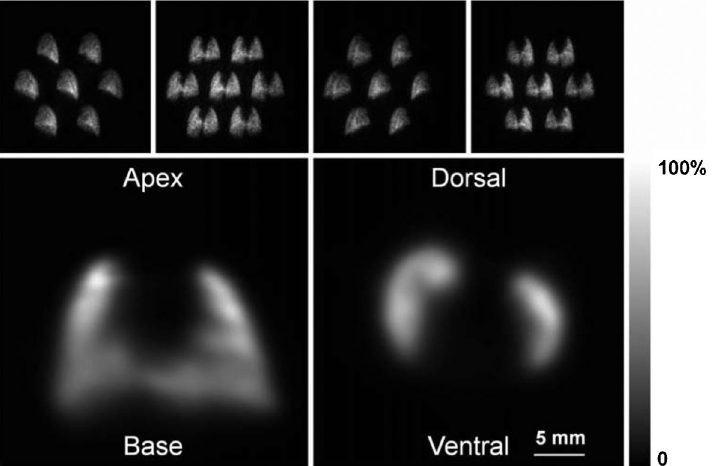
Figure 5. Pulmonary images. Upper panels , sequence of 4 of the 16 projections obtained with the seven-pinhole imaging device of the mouse chest area, labeled with 99m Tc-MAA. Lower panels , characteristic transversal and coronal slices through the reconstructed volumetric model of the radioactive emission from the mouse lungs, after 60 iterations.